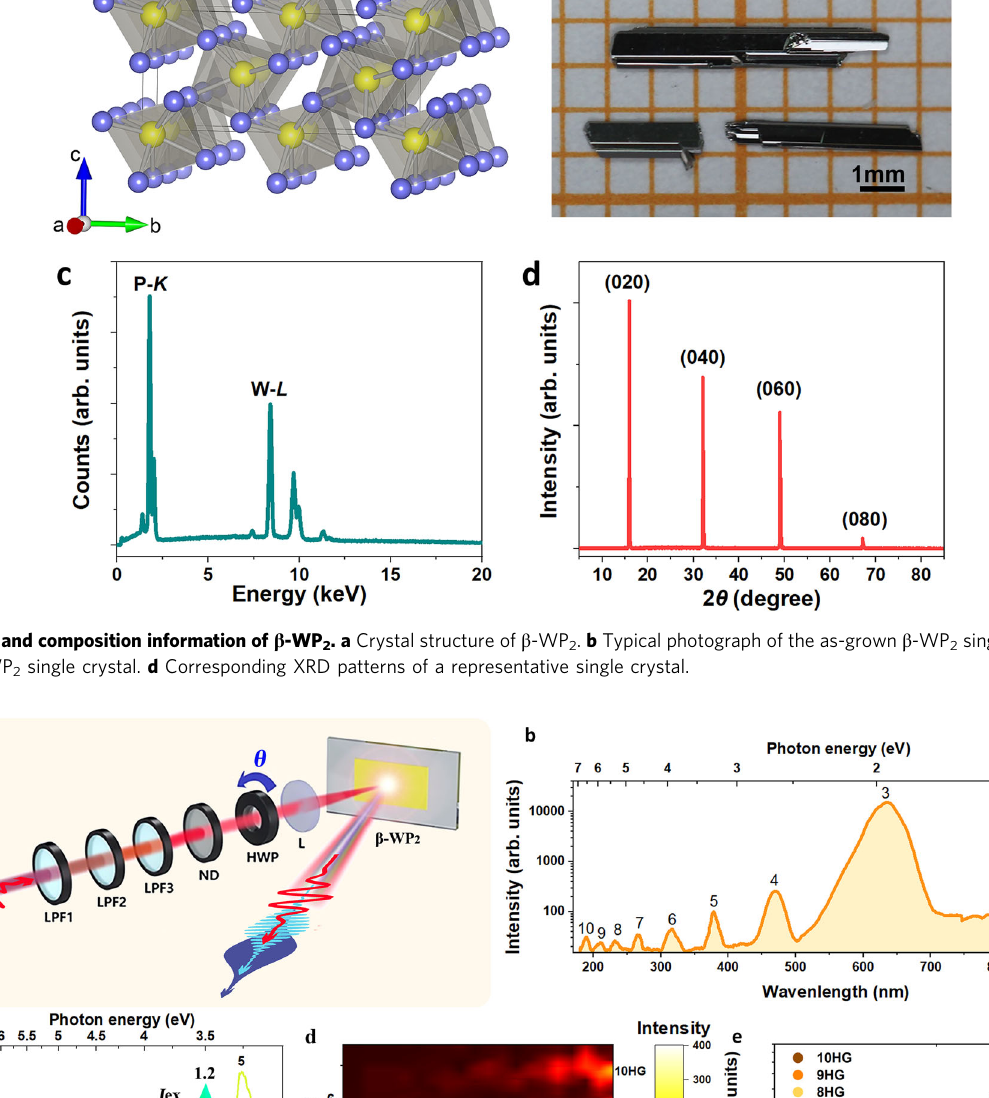
NATURE COMMUNICATIONS| (2021) 12:6437 |https://doi.org/10.1038/s41467-021-26766-y|www.nature.com/naturecommunications